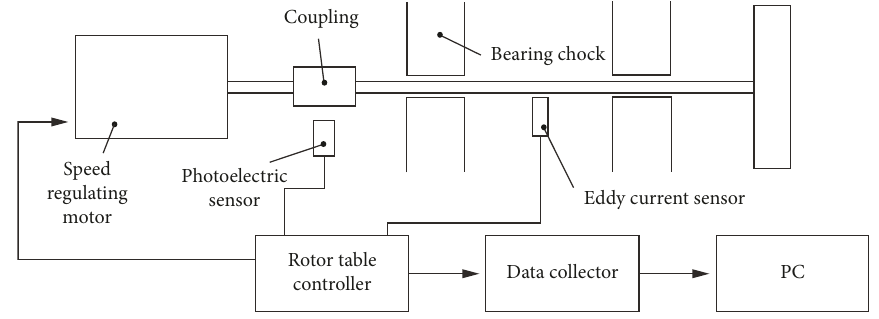
Figure 15: Test system composition diagram. Table 5: Software parameter